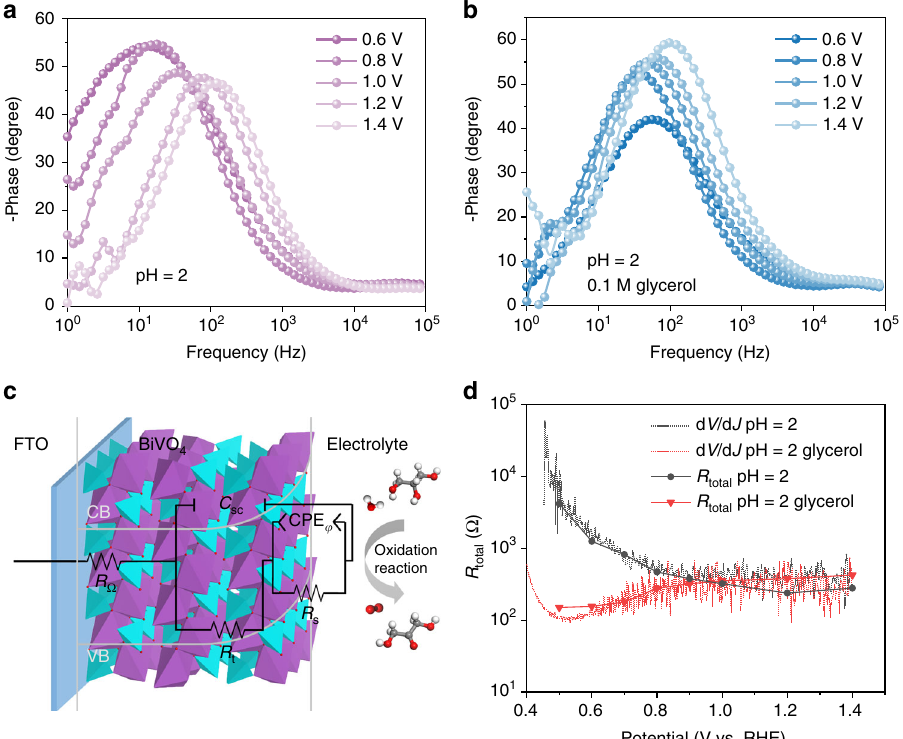
Fig. 2 Charge and mass transfer processes. a , b The Bode plots measured at different potentials under AM 1.5 G, 100 mWcm − 2 illumination without and with the presence of glycerol. c Equivalent circuit used to conceptualize the BiVO 4 photoanode in PEC reactions. d R total calculated from d V d J − 1 of current density-potential pro fi les and from EIS data with and without glycerol under illumination